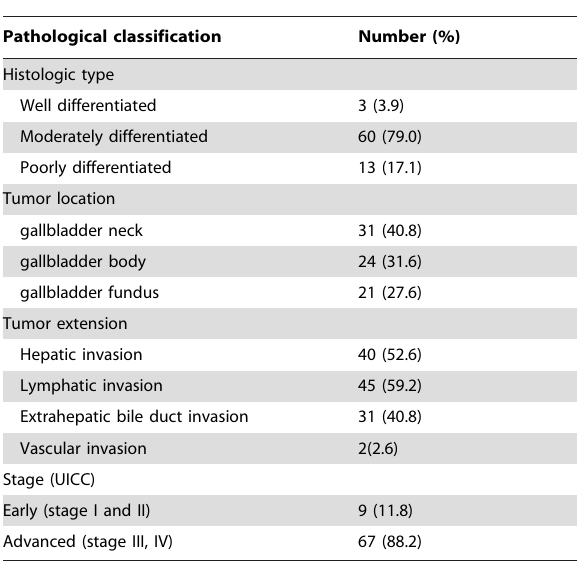
Table 2. Types of 77 hepatectomy performed in the 76 gallbladder cancer patients including a repeat hepatectomy.